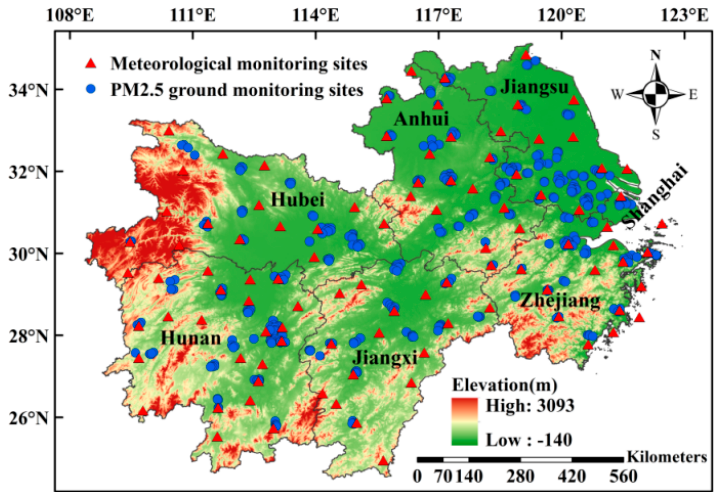
Figure 1. Distribution of meteorological and PM 2.5 monitoring stations.